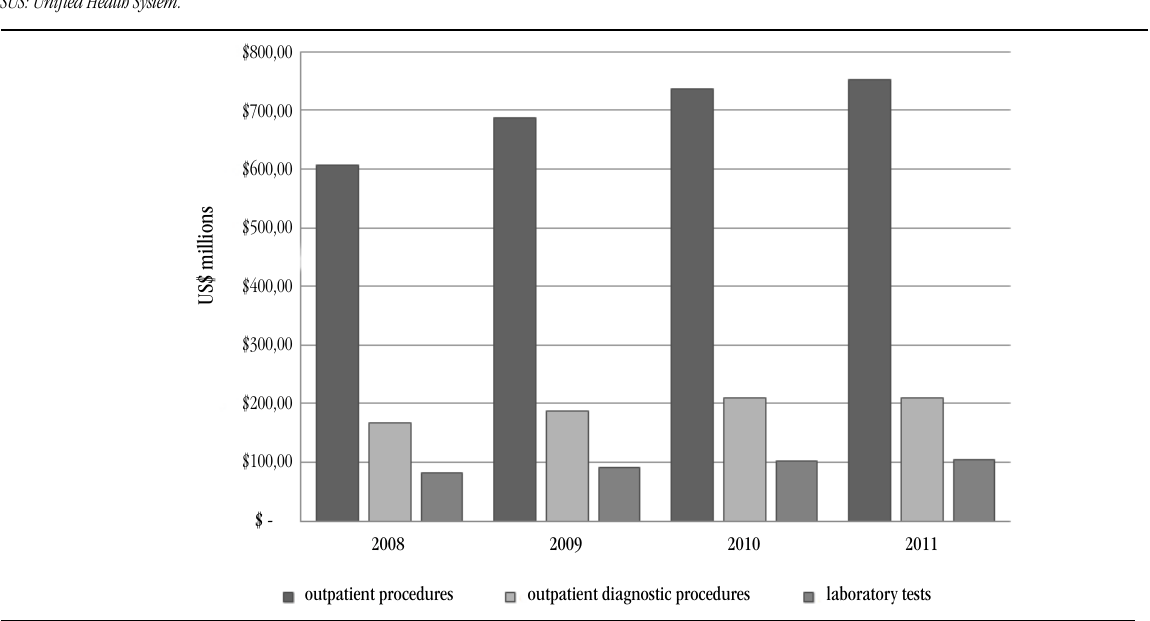
figurE 1 – SUS expenses on outpatient procedures in Brazil per state, 2011 (US$ billion) Source: DATASUS, 2012 (12) . SUS: Unified Health System.